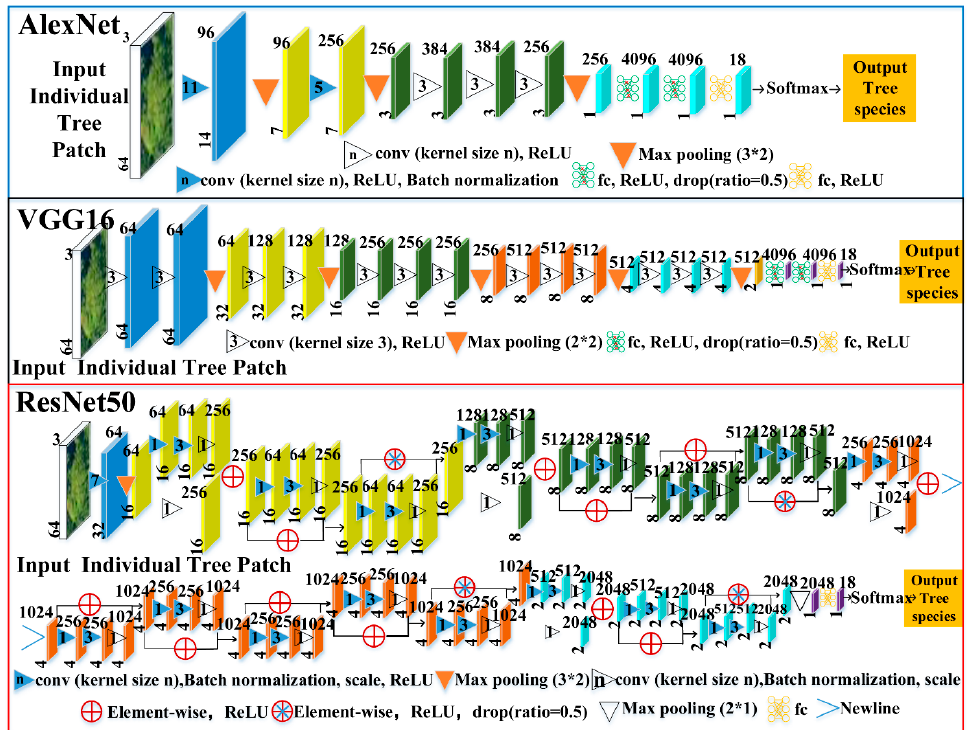
Figure 4. The architectures of the three deep convolutional neural networks used in our tree species classification. Adapted from Krizhevsky et al. [38], Simonyan and Zisserman [39], and He et al. [41]. The numbers on the top of each box are the number of bands of the feature maps, while the numbers on the bottom are the size (height and width) of the feature map.